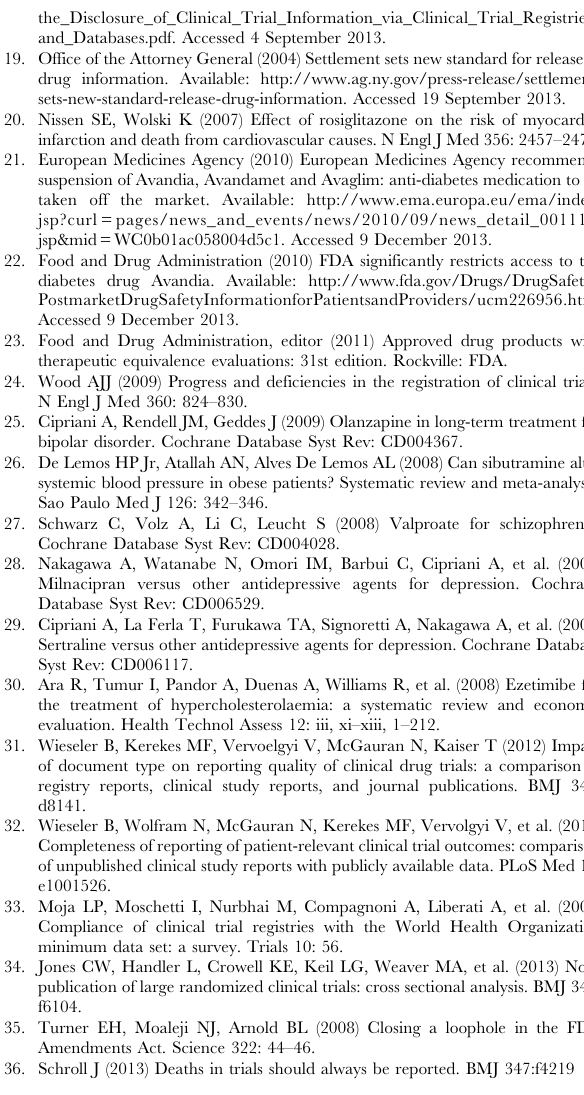
Table S2 Number of drugs for which additional trial(s) or data were found in industry results registries, according to year of drug approval. Table S3 Inclusion rate of results registries in system- atic reviews of drugs identified in PubMed in August 2013 (search